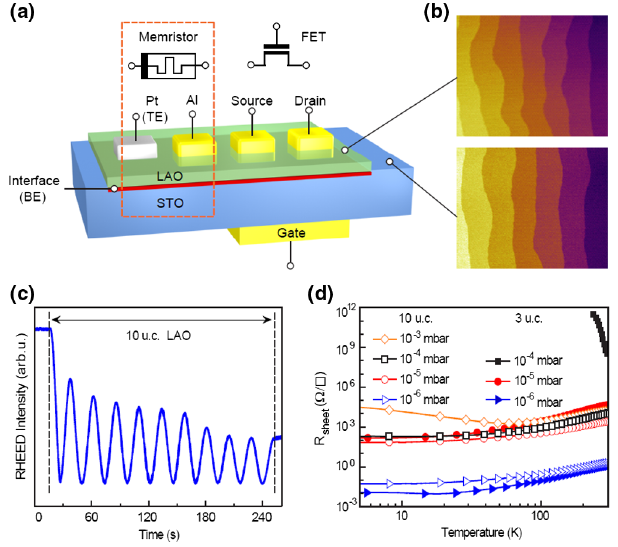
FIG. 1. (a) Proposed scheme of integrating both the high- performance memristor and field-effect transistor at the oxide interfaces. The conducting interface that serves as the bottom electrode is contacted using Al wire bonding. A positive bias is defined as current flowing from the top Pt electrode into the device. (b) Atomic-force-microscopy images taken on the TiO 2 -terminated STO substrate as well as after the growth of 10-u.c. LAO. (c) Typical RHEED oscillation observed in situ during the PLD thin-film growth. (d) Temperature dependence of sheet resistance measured for the n -type LAO/STO interface in 3- and 10-u.c. LAO films grown at various partial oxygen